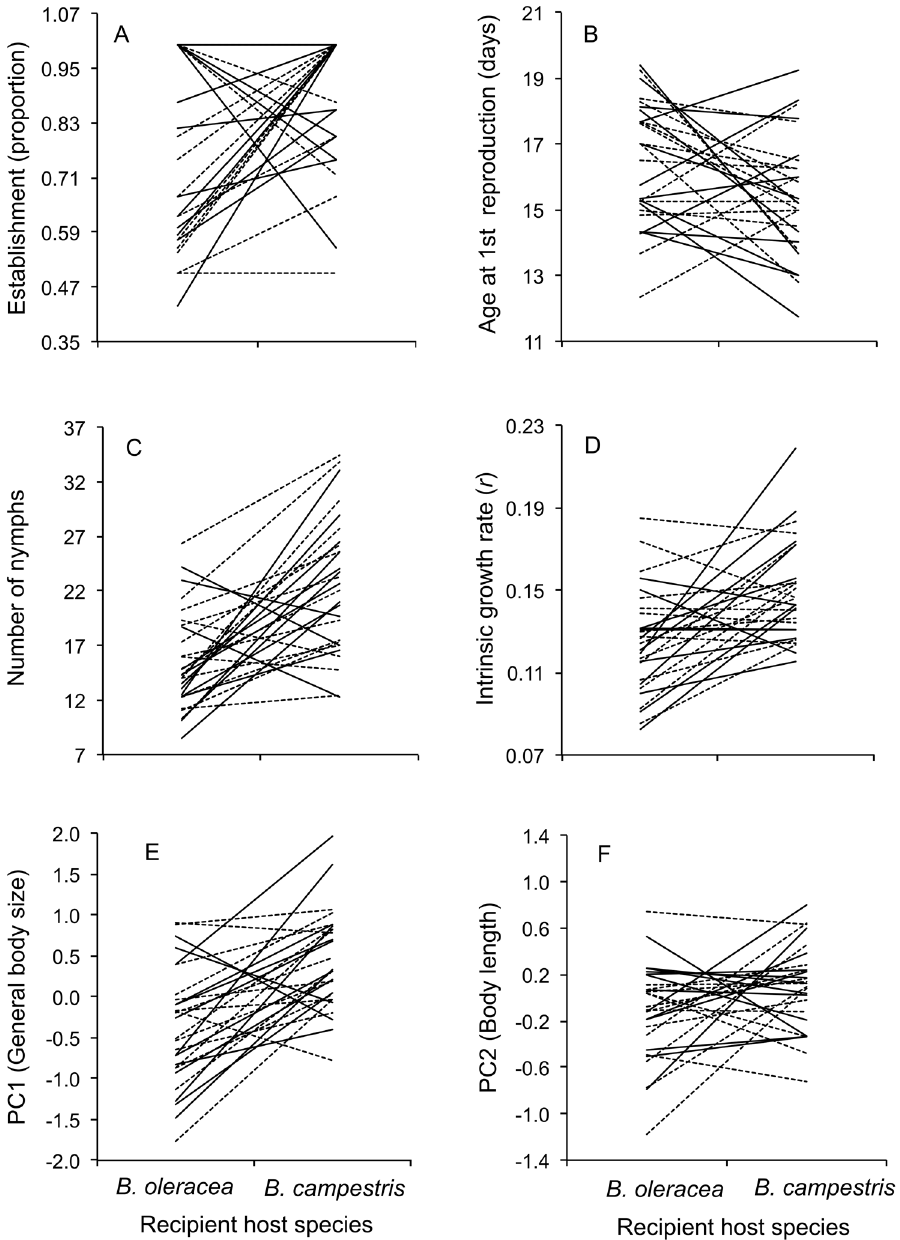
Figure 2. Reaction norms of 27 genotypes of Brevicorynebrassicae reared in Brassicacampestris and B.oleracea . Points are the average value of 4–5 individuals of the same genotype. Genotypes were collected from B. campestris (solid lines) and B. oleracea (dashed